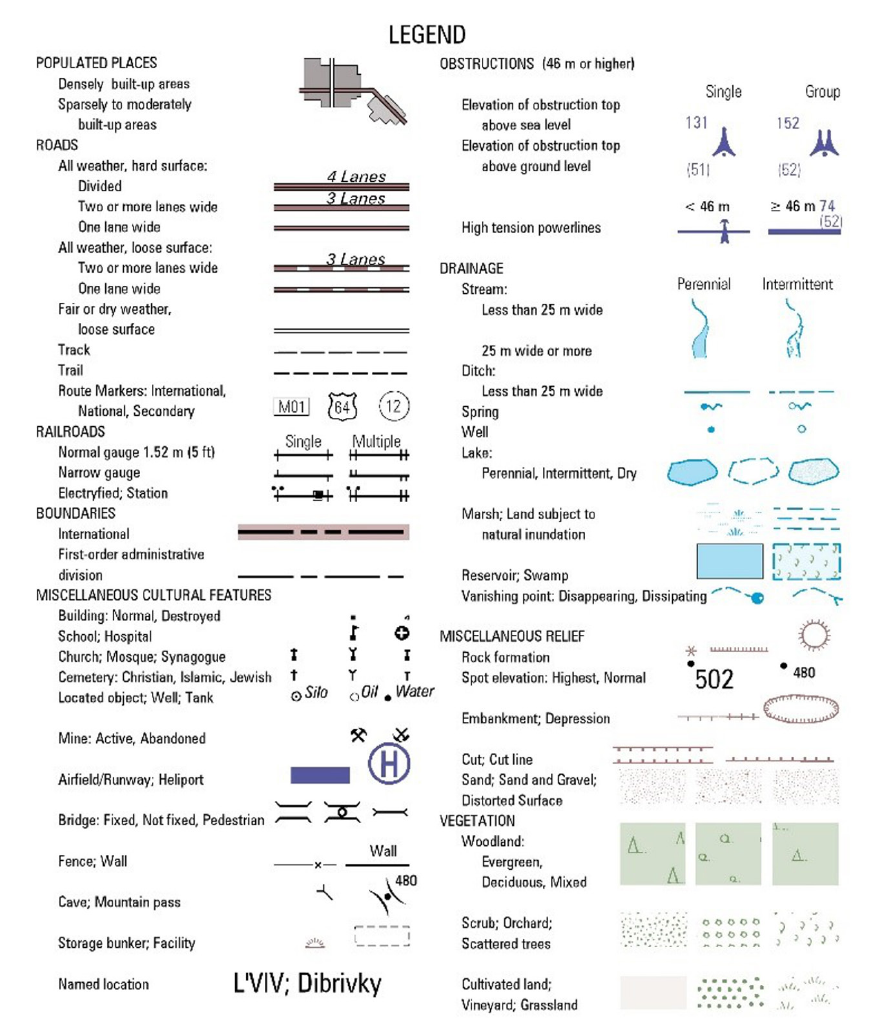
Fig. 3. Legend symbols